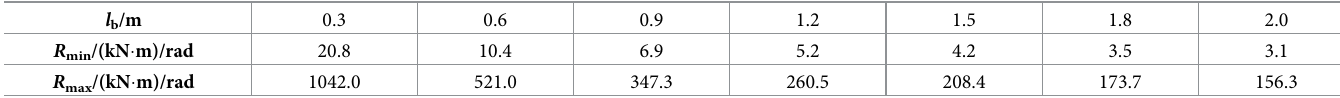
Table 5. Regional boundary of initial bending stiffness of the semi-rigid joint with different transverse and longitudinal distances in model of B-SG.